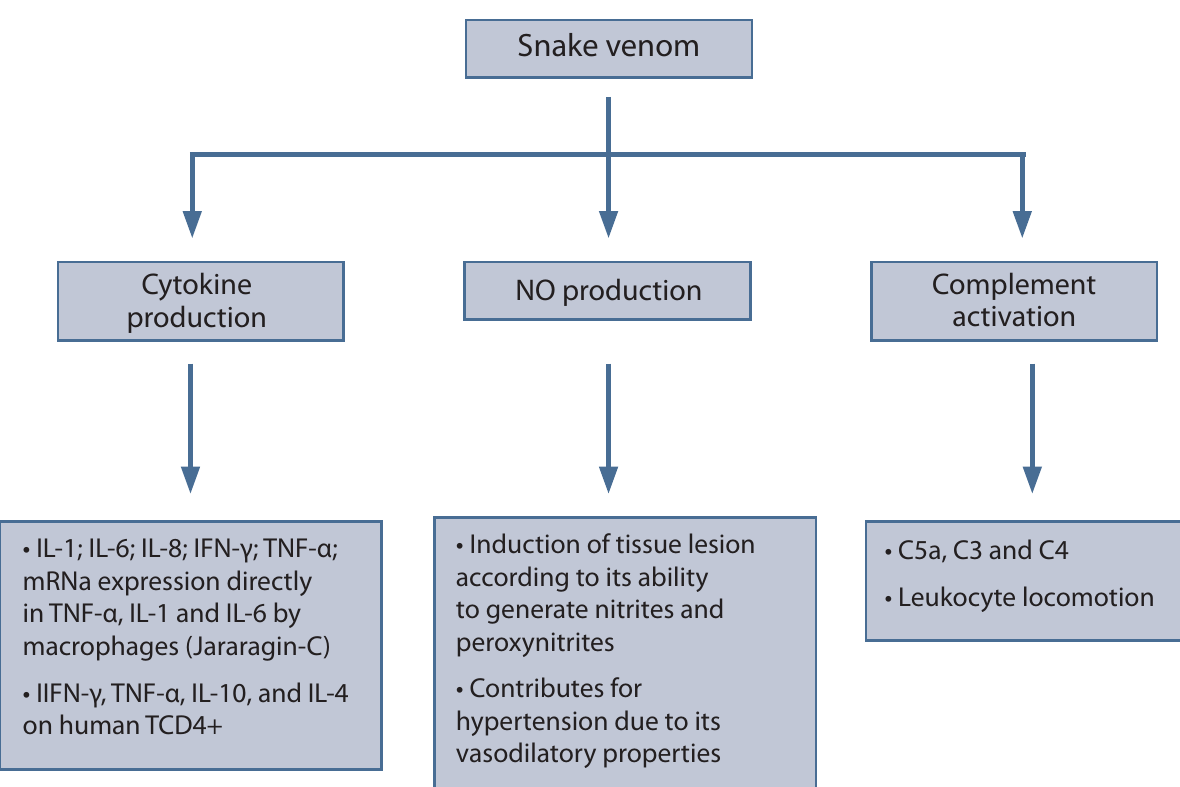
Figure 1. Production and activation of mediators by snake